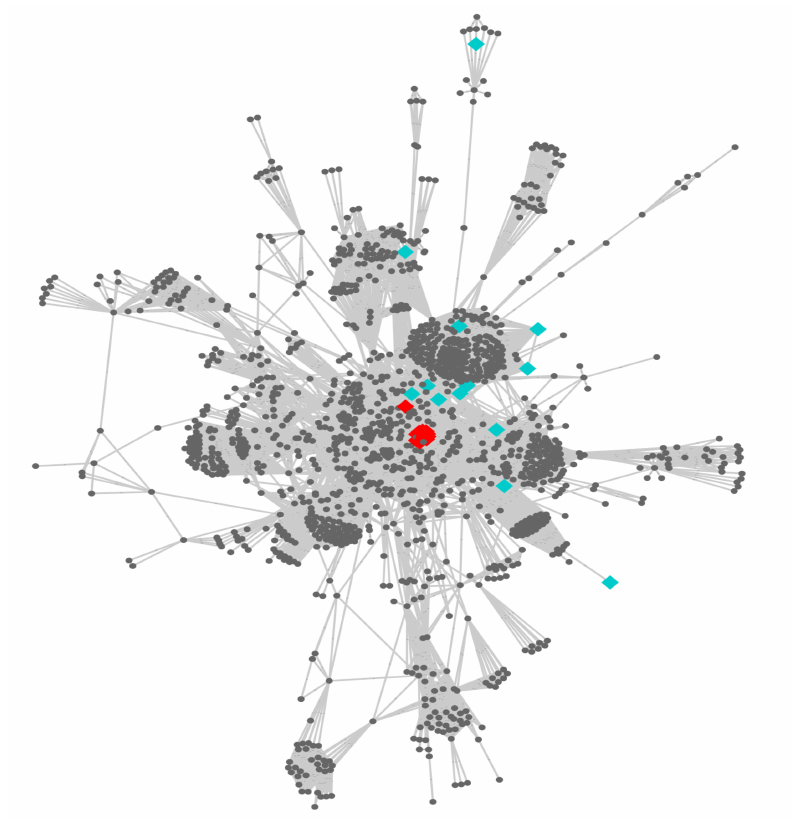
Figure 5. Subnetwork of interactions associated with the triad of identified kinases GSK (magenta), AKT-like (green) and CDK (blue) from L. major . The three proteins are directly interconnected and regulate relevant pathways on the parasite (yellow nodes) that are potentially associated with the PI3K/AKT